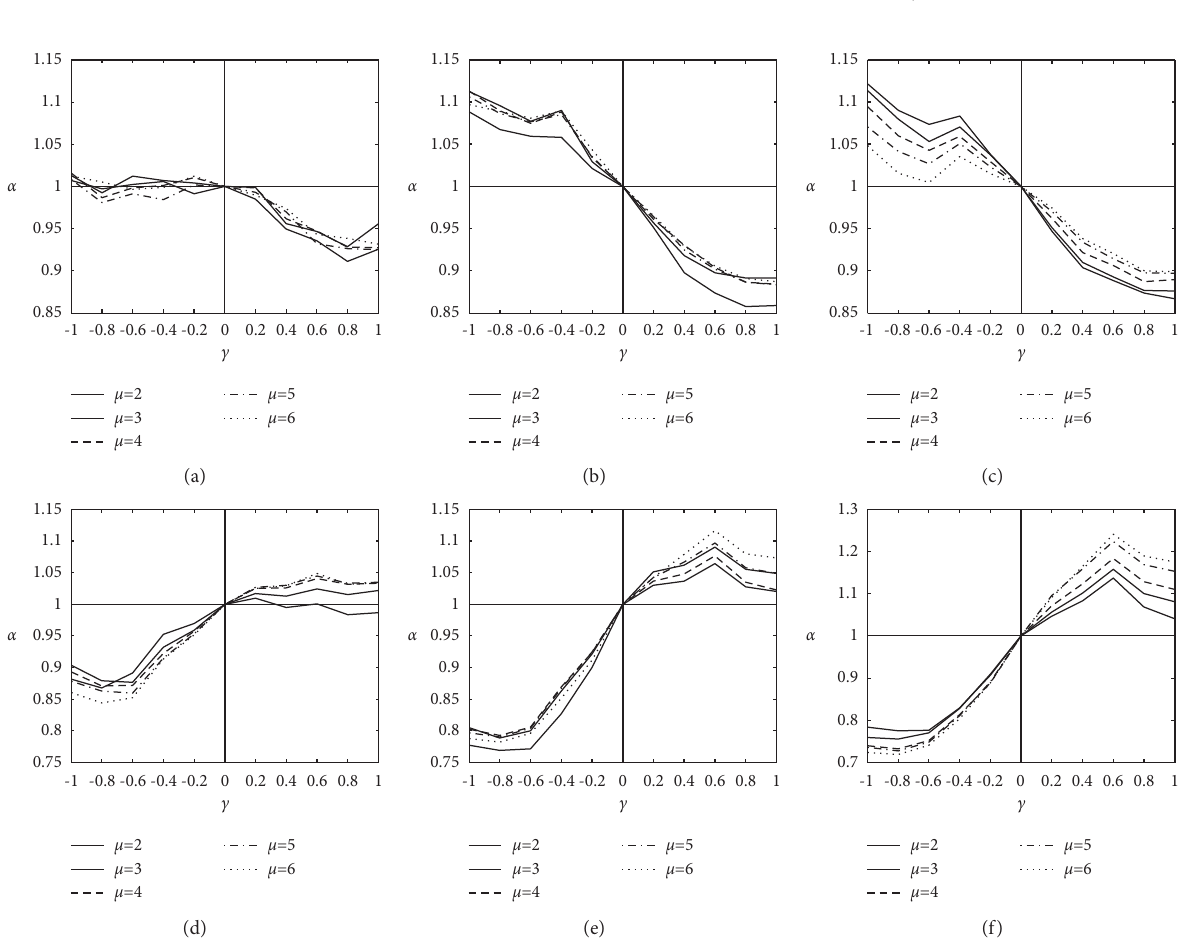
Figure 6: The curves of α of constant ductility factors for hard soil site. (a) T � 0–0.5 s. (b) T � 0.5–1.0s. (c) T � 1.0–2.0 s. (d) T � 2.0–3.0s. (e) T � 3.0–4.0s. (f) T � 4.0–5.0 s.